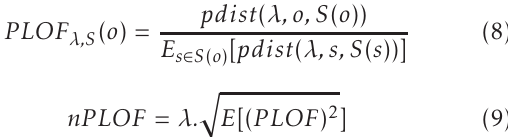
Figure 7. Example of anomaly based on assumption